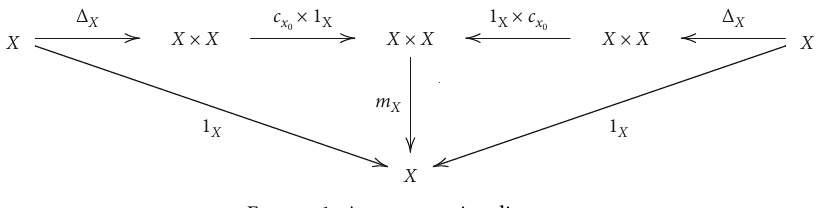
Figure 1: A commutative diagram.